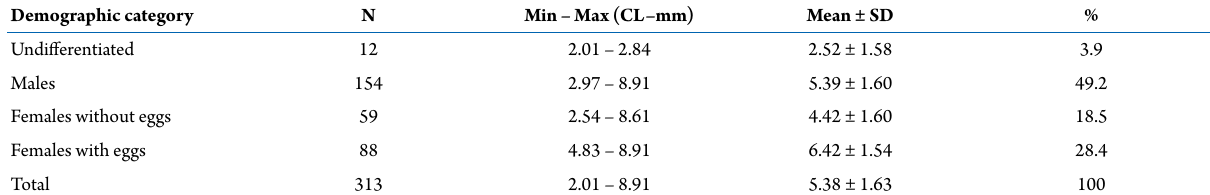
Table 1. Alpheus brasileiro Anker, 2012. Carapace length of each demographic category of the population of Cananéia, São Paulo state, south–eastern Brazil from April 2015 to March 2016.